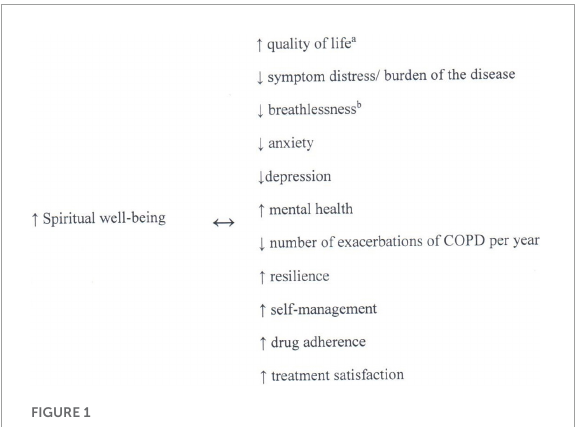
FIGURE1 Associations between spiritual well-being and clinical outcomes (17–24, 29, 34). Non-casual-relationships can be proved on the base of studies identified. a no association in patients with COPD in a study by Hasegawa et al. (20). b no association in a study by Delgado et al.